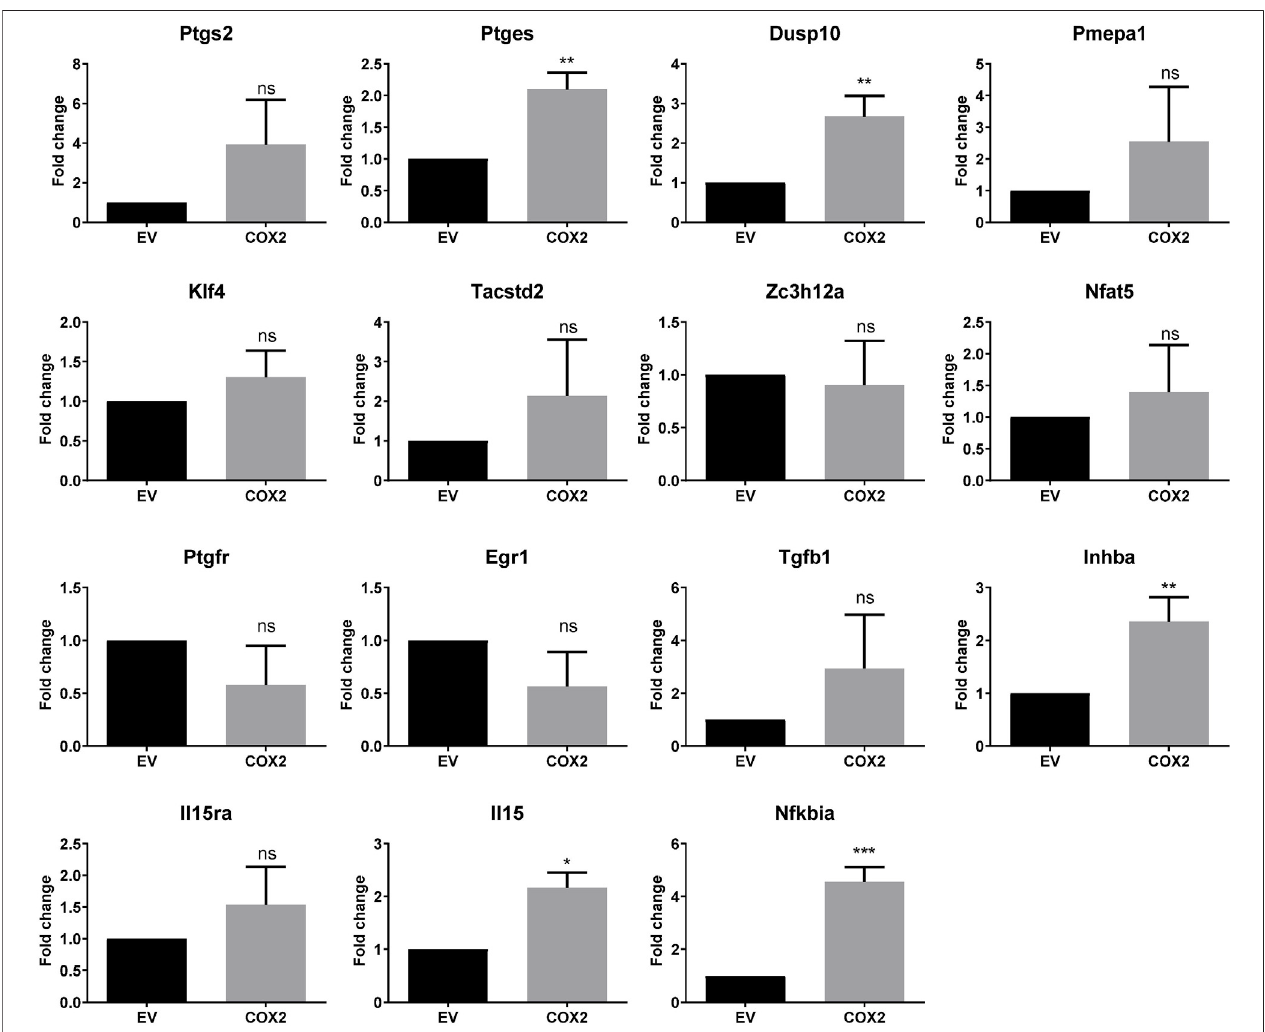
FIGURE 1 | COX2-regulated gene expression in CT29 cells. Fold change of mRNA levels in CT29- COX2 cells compared to the empty vector ones (EV) as estimated by RT-qPCR. Statistically signi fi cant differences were tested using the unpaired t test. ns: not signi fi cant; *: p < 0.05; **: p < 0.001; ***: p < 0.0001.